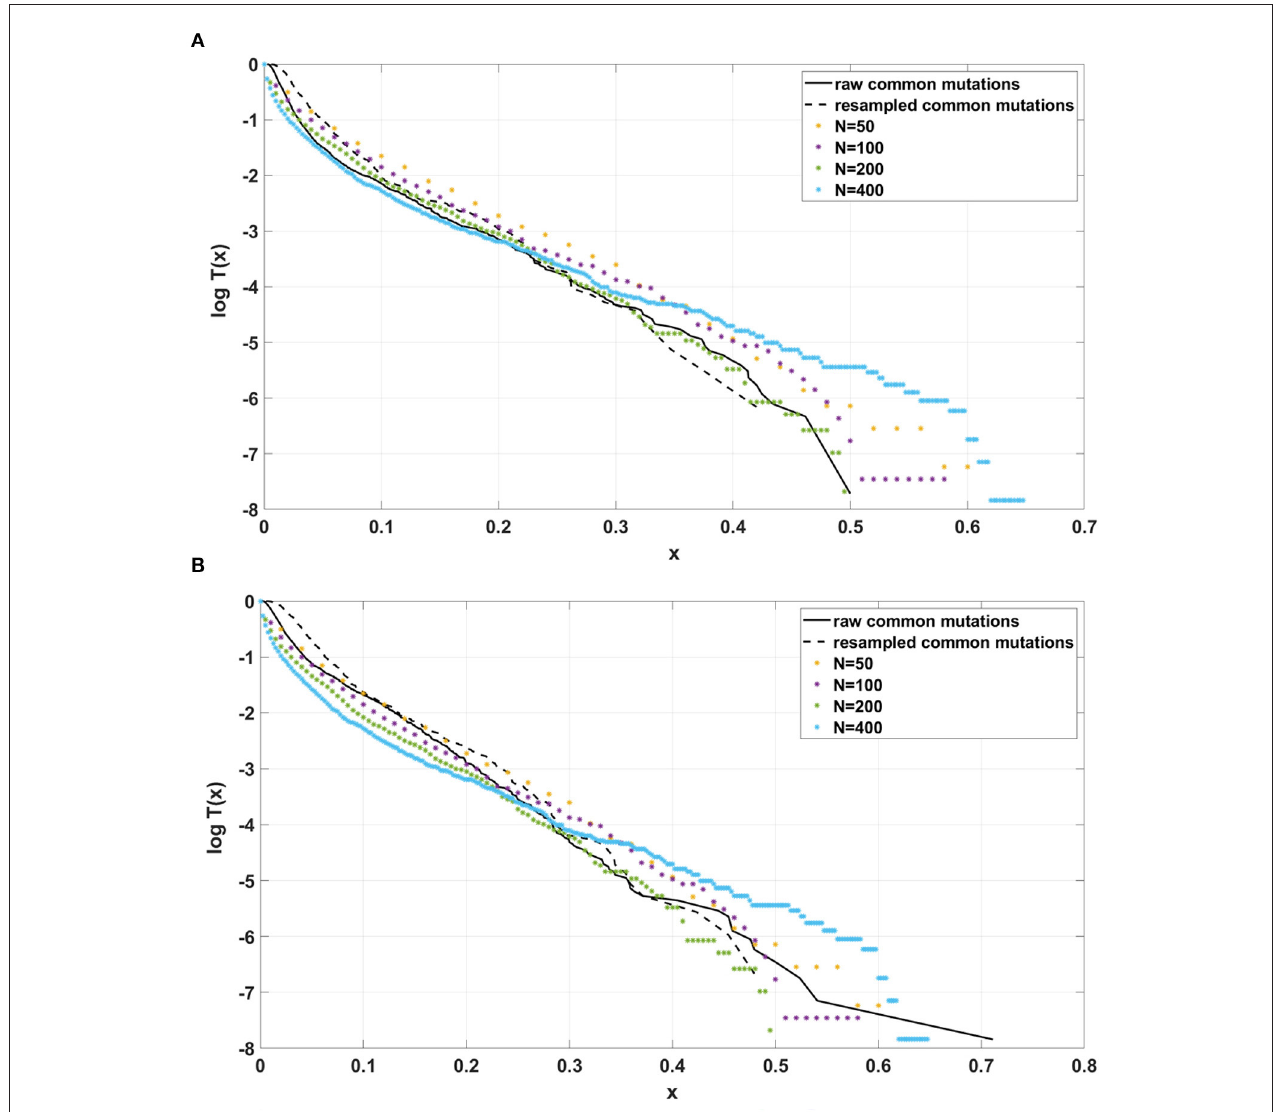
FIGURE 12 | Comparison of semi-logarithmic cumulative tails of the SFS obtained for experimental data from (A) patient G30 and (B) patient G31 with four sets of simulations with parameters: s = 0.5, d = 0.0001, p = 0.01, L = N µ = 6, and variable population size N